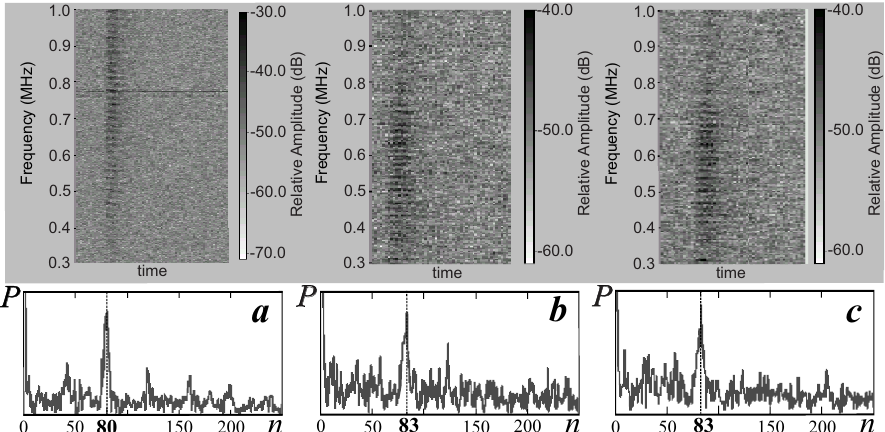
Fig. 4. Top panels. Dynamical spectra of the elliptically polarized radiation of the three anomalously strong pulses of PSR B0809+74 registered with UTR-2 ( F c = 23.7 MHz, ∆ F = 1.53 MHz). Lower panels. The polarization responses ( P = j ˙ P ( n, t ) j 2 ) near the maximum intensity of each